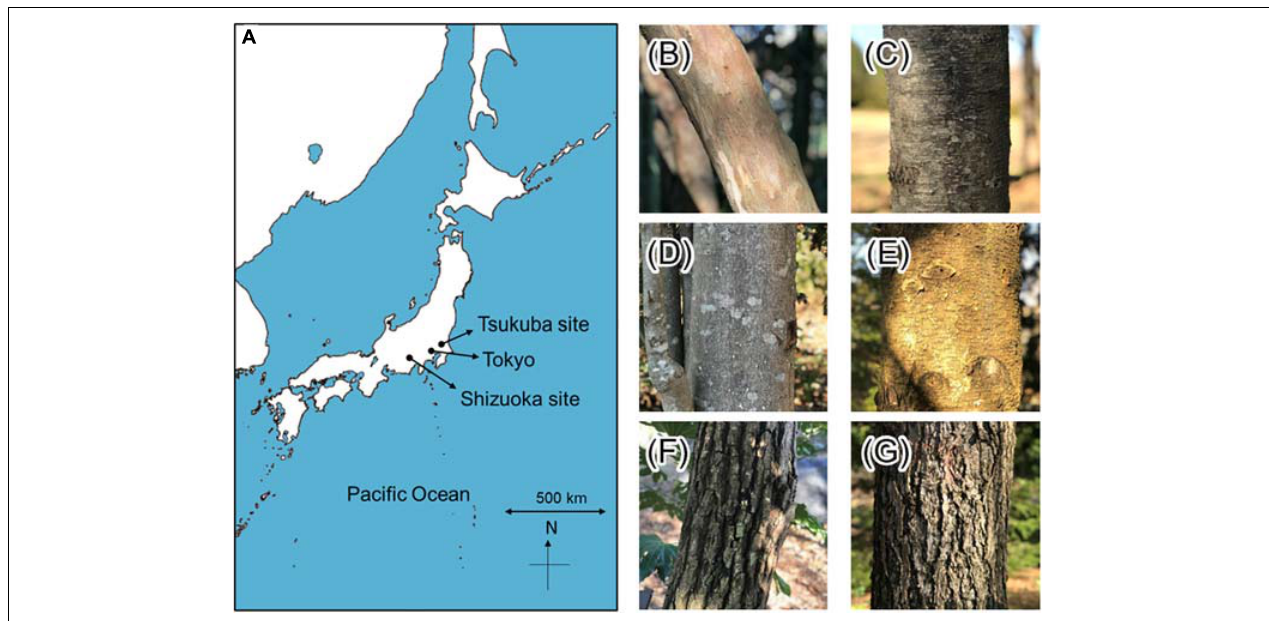
FIGURE 1 | (A) The study sites. The map scale is 1:5,164,000. The bark morphology of target species. (B) Clethra barbinervis , (C) Padus grayana , (D) Magnolia obovata , (F) Abies firma , (G) Castanea crenata , and (H) Tsuga diversifolia. The bark morphology of Tsuga sieboldii is the same as T. diversifolia .